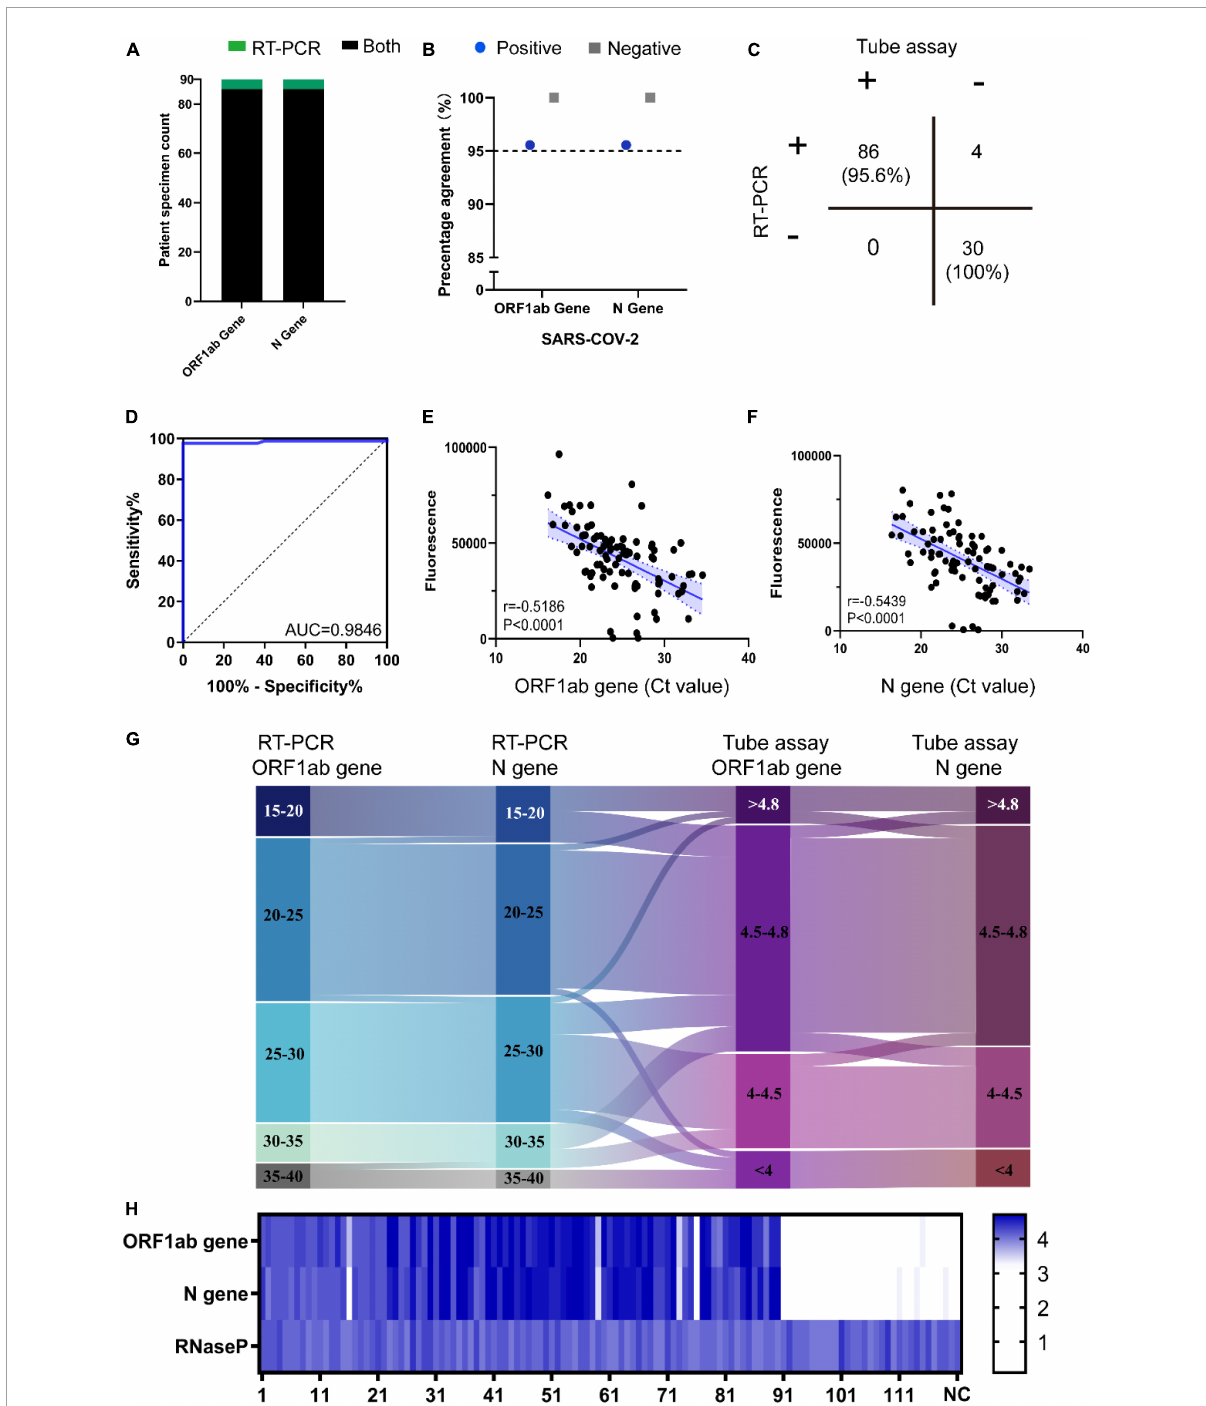
FIGURE5 Clinical validation of the optimized reaction system. (A) Comparison of the performance of RT-PCR and the visualized method on 90 SARS-CoV-2 patient specimens. Black: genes correctly identified by both Integrated tube assay and RT-PCR. Green: RT-PCR only. (B) Positive and negative percentage agreement for genes on the assay. Blue: positive; Black: negative. (C) Concordance of the performance of RT-PCR to this assay for 120 clinical samples. (D) The receiver operating curve (ROC) analysis. (E) Pearson correlation analysis was used to analyze the correlation between the Ct values of ORF1ab gene and the fluorescent intensity values. (F) Pearson correlation analysis was used to analyze the correlation between the Ct values of N gene and the fluorescent intensity values. (G) The sankey diagram showing the correlation between the range of Ct values and the fluorescent intensity values. (H) Normalized fluorescence signal for each SARS-CoV-2 positive sample on the reaction